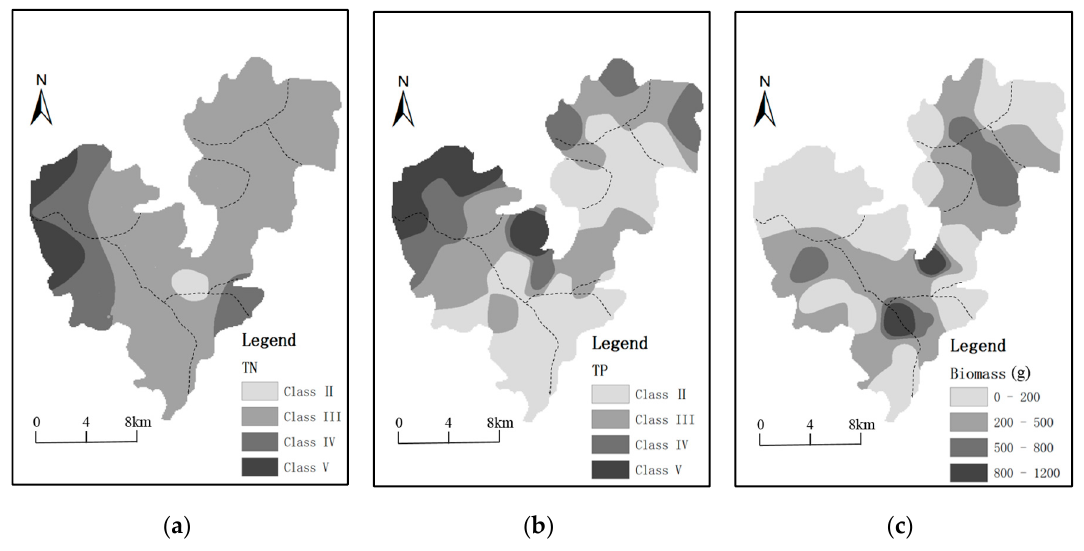
Figure 6. Spatial variability in TN, TP and biomass in the wet season: ( a ) TN; ( b ) TP; and ( c ) Biomass.